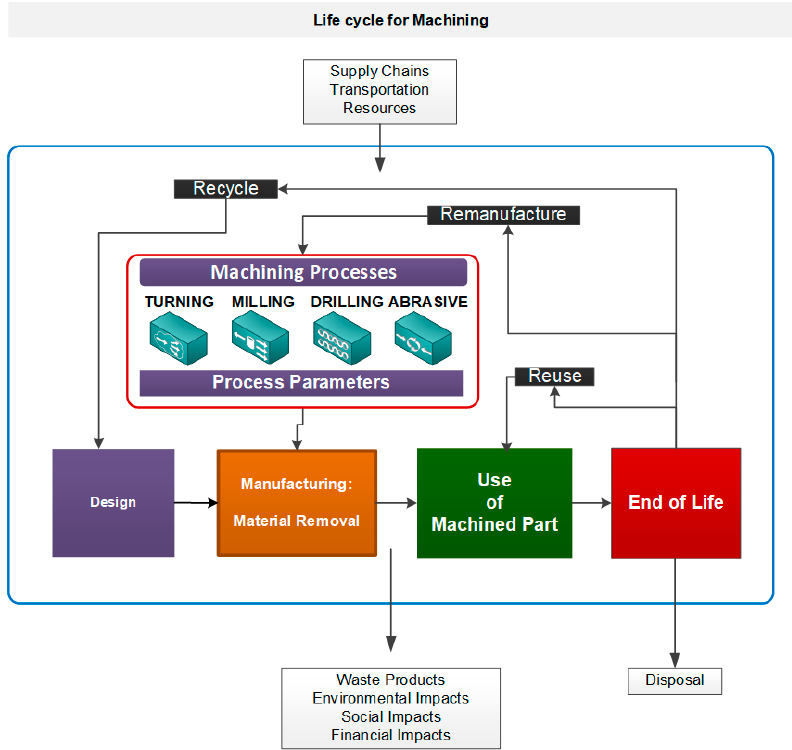
Figure 4. Main product life cycle phases where the activity model is positioned.